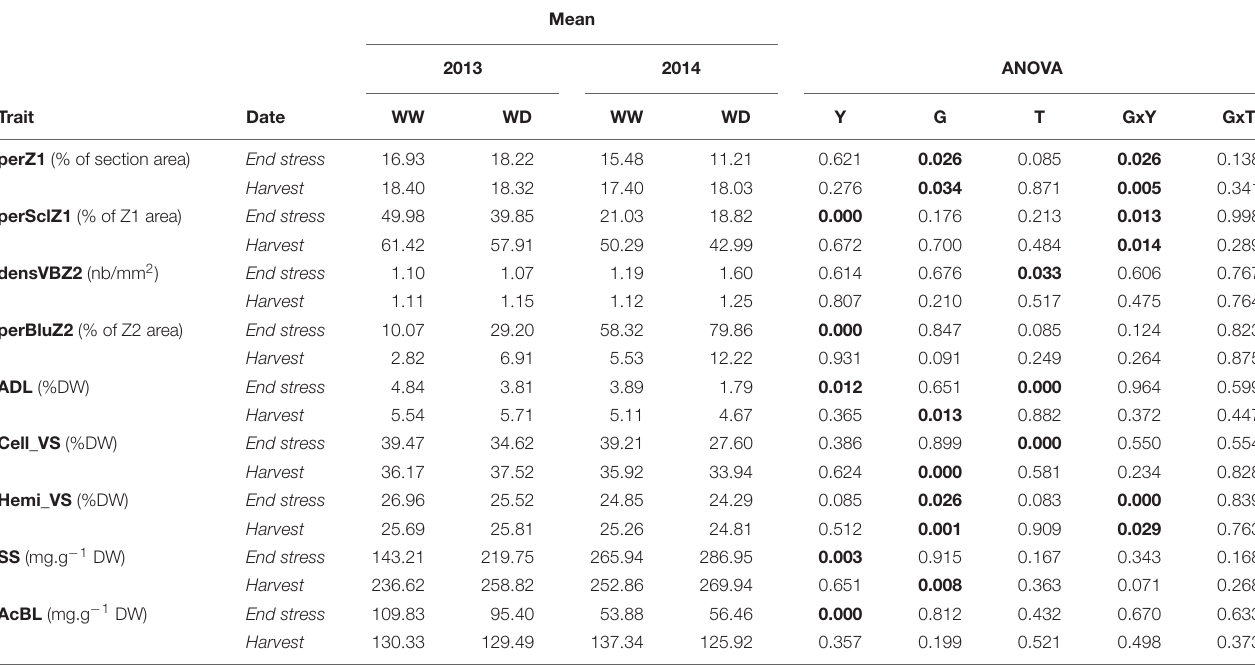
TABLE 3 | Mean values and corresponding ANOVA results for anatomical (perZ1: outer zone area (Z1) in % of internode section area, perSclZ1: percentage of sclerenchyma tissue (red stained) in % of Z1 area, densVBZ2: density of vascular bundles in central zone (Z2) in number of vascular bundles per mm 2 and perBluZ2: percentage of blue tissue in % of Z2 area) and biochemical (ADL: Acid Detergent Lignin in %DW, Cell_VS: cellulose content in %DW, Hemi_VS: hemicellulose content in %DW, SS: soluble sugars in mg.g − 1 DW and AcBL: lignin content by acetyl bromide method in mg.g − 1